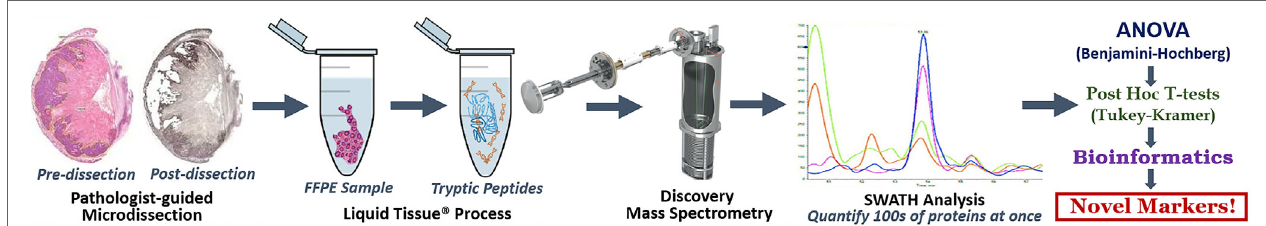
FIGURe 1 | Discovery LT­SWATH­MS Workflow. H&E stained sections of our specimen were marked by a board­certified pathologist and used as a guide for microdissections of serial sections stained with hematoxylin. We aimed to attain 12–15 mm 2 of pure tumor, Barrett’s esophagus (precancerous tissue) or normal squamous esophageal epithelium in each sample. Pre­ and post­microdissection images were taken to ensure that tissue retrieval occurred within the specified margins. The microdissected formalin­fixed paraffin­embedded tissue was placed in Eppendorf tubes and covered in roughly 40 µL of Liquid Tissue ® buffer and through a series of heating and digestion stages turned our fixed tissue into a mass spec­friendly lysate. The resultant digest was quantified for protein concentration via nanodrop, cleaned via MCX, and analyzed by TripleTOF mass spectrometry. SWATH analysis and our outlined series of biostatistics (ANOVA, Benjamini– Hochberg procedure, post hoc T ­tests, Tukey–Kramer range test), and simple bioinformatics yielded a list of a dozen markers, never before described as being involved in EAC